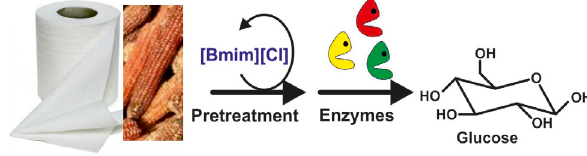
Figure 1 Schematic representation of the sustainable protocol for the enzymatic saccharification of ionic liquid (IL)-pretreated lignocellulosic biomass, and the recycling of the ionic liquid 1-butyl- 3-methylimidazolium ([Bmim][Cl]).